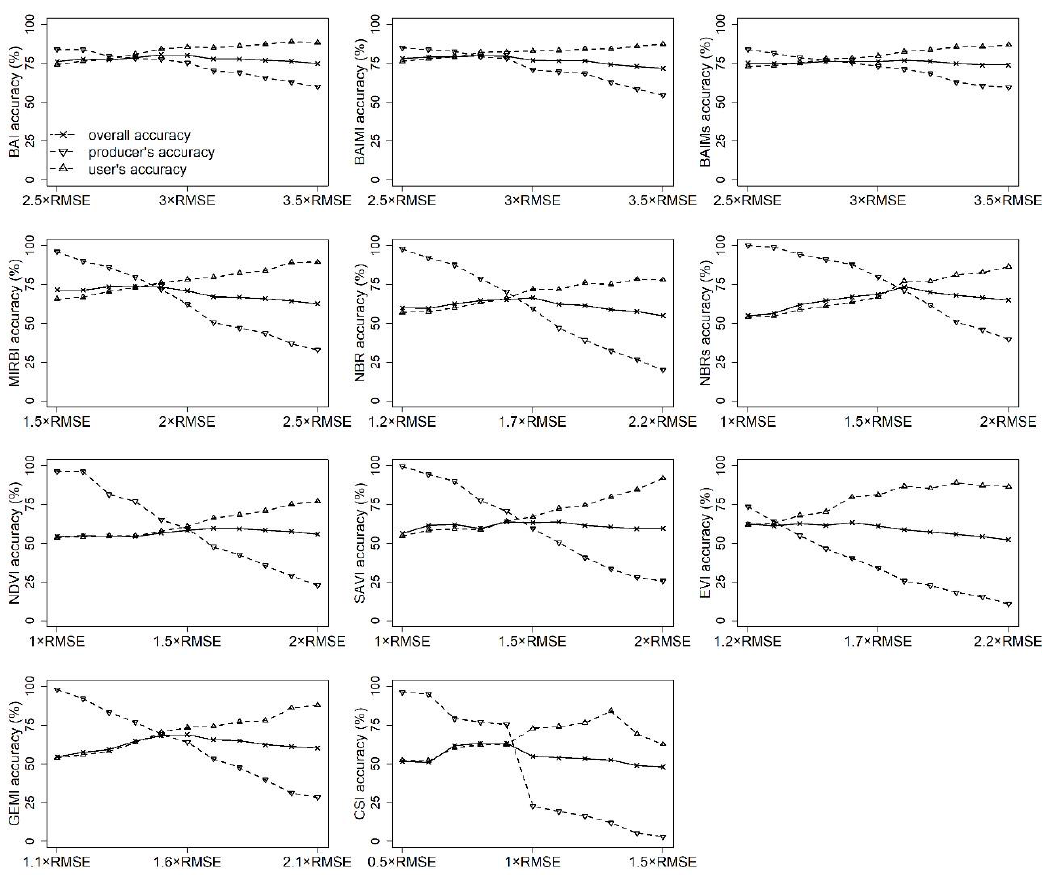
Figure 3. Overall accuracy and producer’s and user’s accuracies for different spectral indices as a function of threshold value.